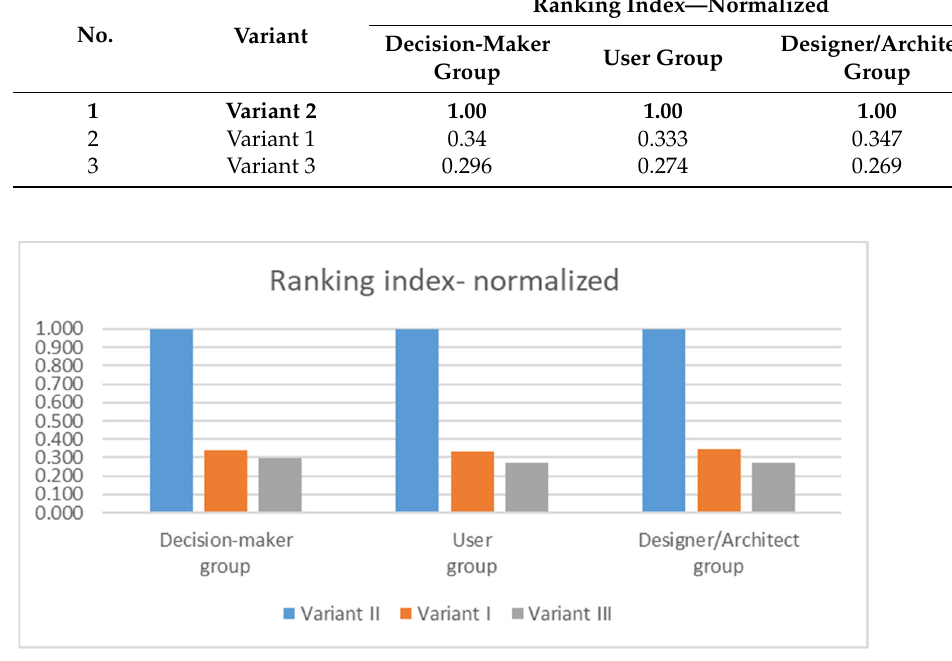
Figure 2. Final ranking of variants—normalized.